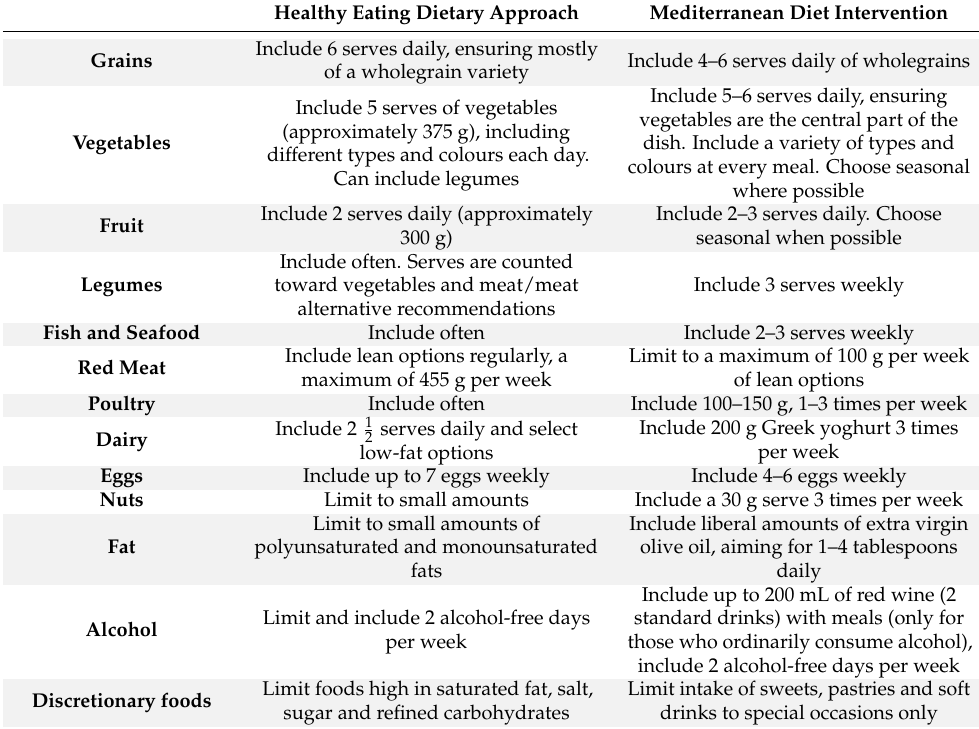
Table 2. Recommended foods and serve sizes for the two dietary